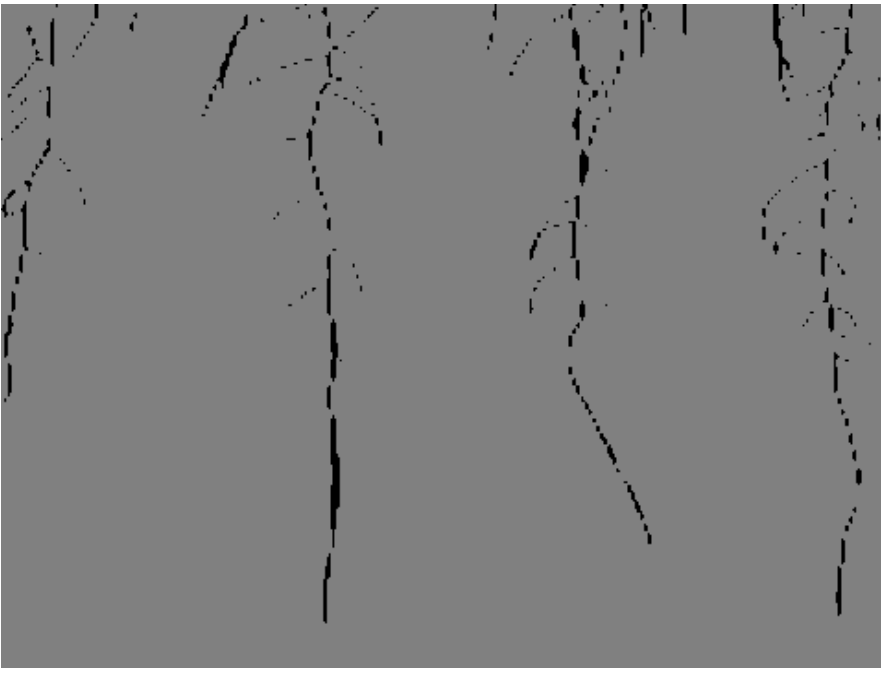
Figure 11. Example of semantic segmentation results from our trained SegNet model. The main and lateral root architectures are successfully segmented, but there are small gaps along them.